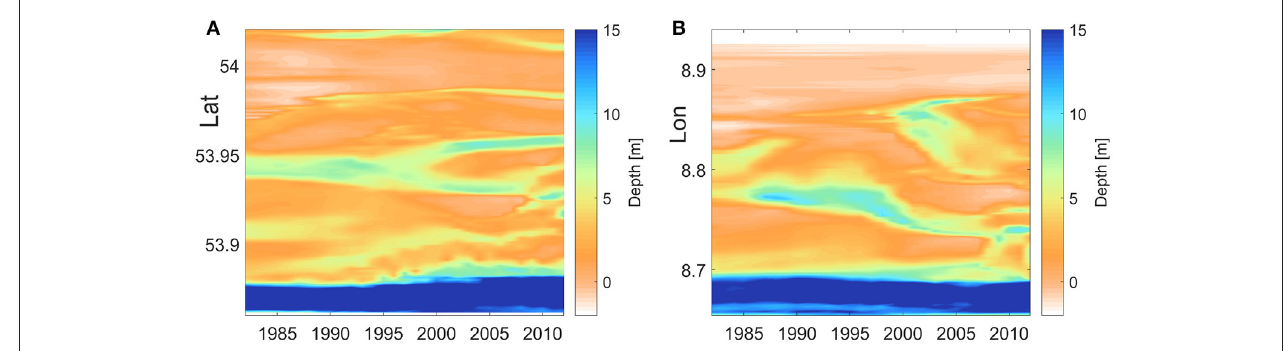
FIGURE 4 | Time vs. distance diagrams of bathymetry west of the Elbe Estuary along meridional (A) and zonal (B) sections shown in Figure 3A .